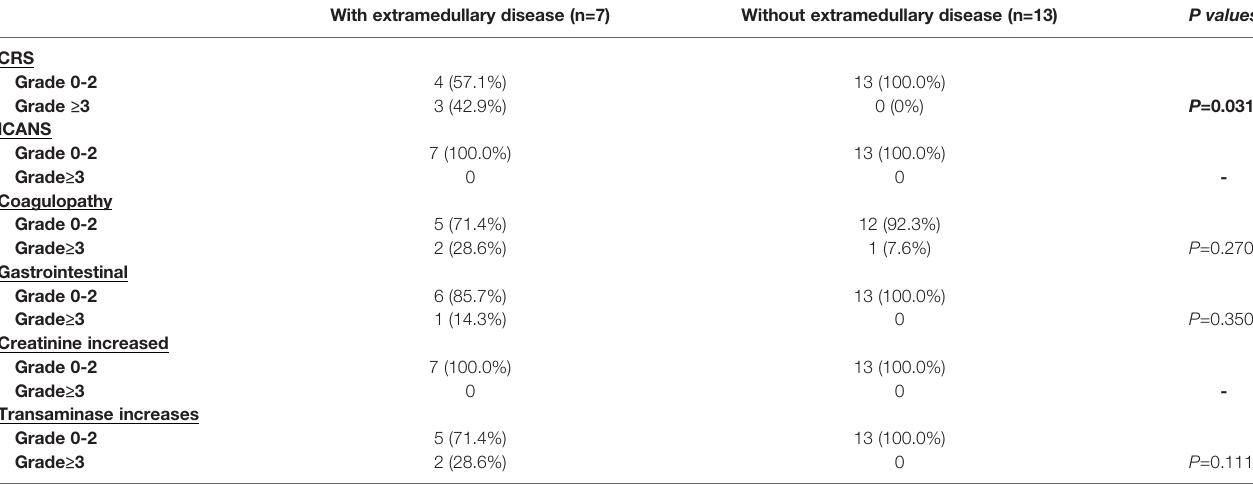
TABLE 3 | Adverse events in the anti-BCMA-CAR T cell therapy. With extramedullary disease (n=7) Without extramedullary disease (n=13) P